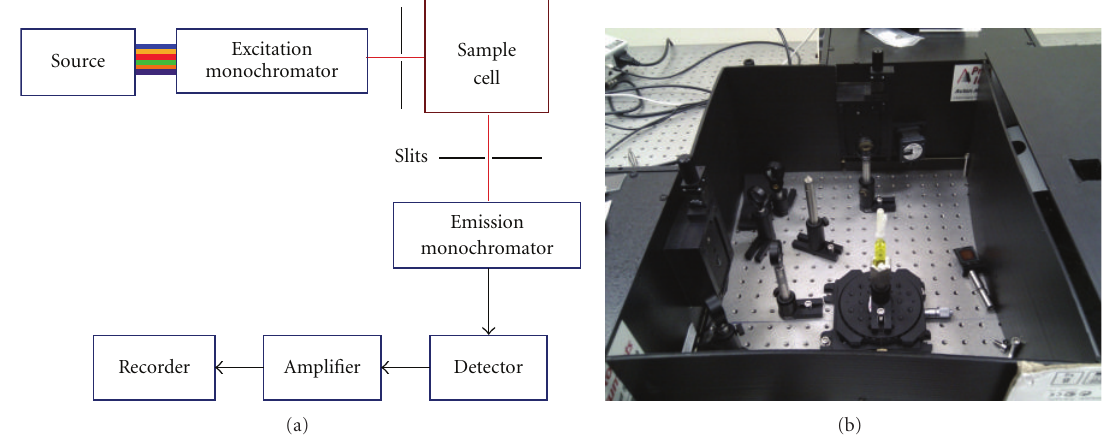
Figure 1: Experimental setup, (a) block diagram and (b) part of the actual setup.